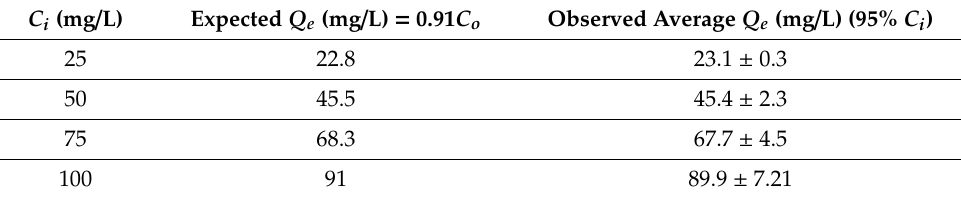
Table 2. Observed and expected total adsorptions for different initial concentrations. The expected value of the adsorption was 91% of the initial concentration taken from the average equilibrium adsorption measurements after three days.